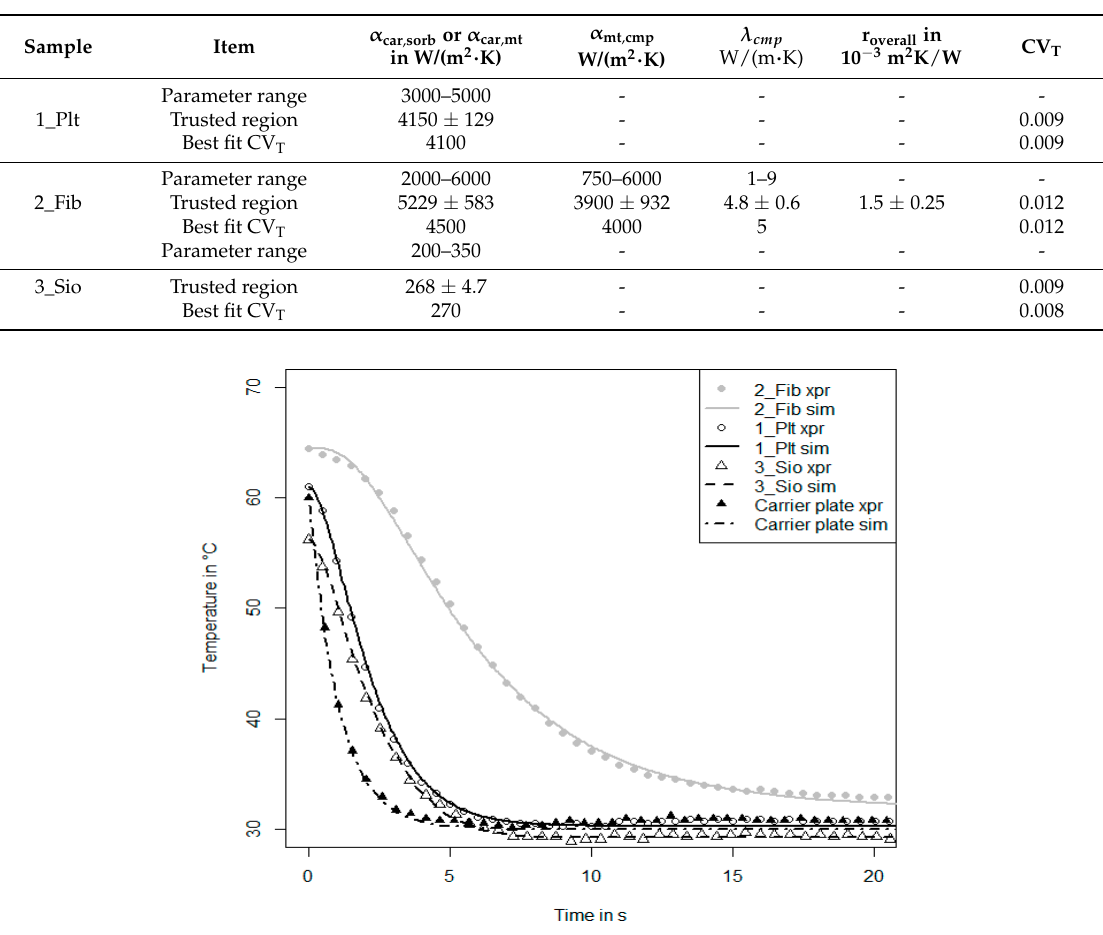
Figure 5. Temperature curves for inert-LTJ measurements on three different samples and the corresponding simulations. Table 8. Identified heat transfer parameters for the inert-LTJ measurements under desorption conditions for three different samples.